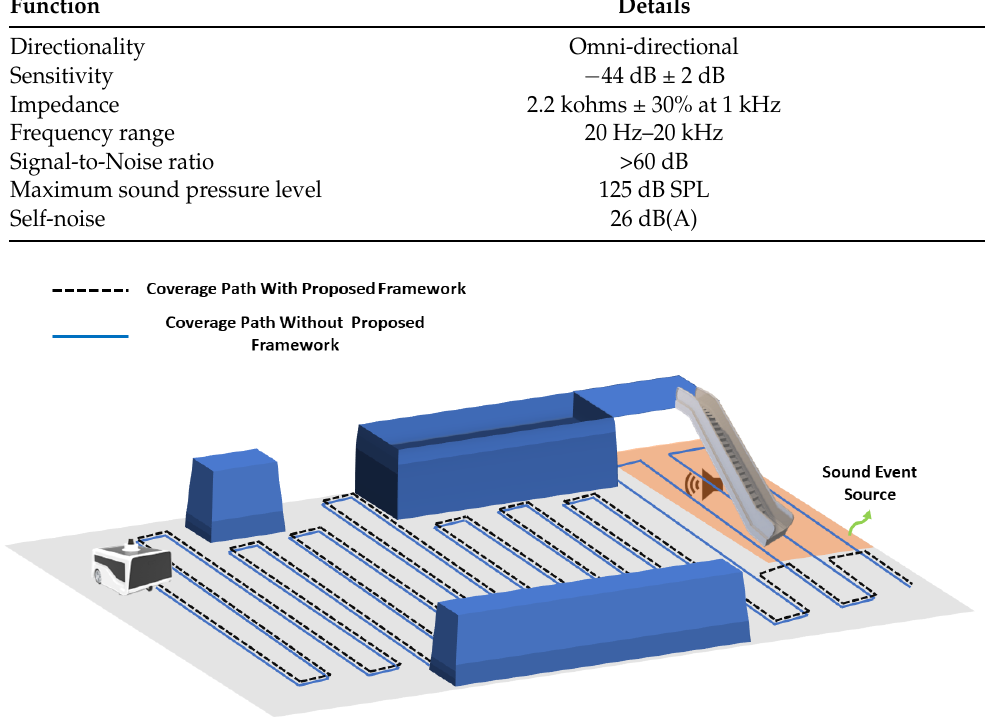
Figure 1. Cleaning robot generating coverage path with and without sound source avoiding